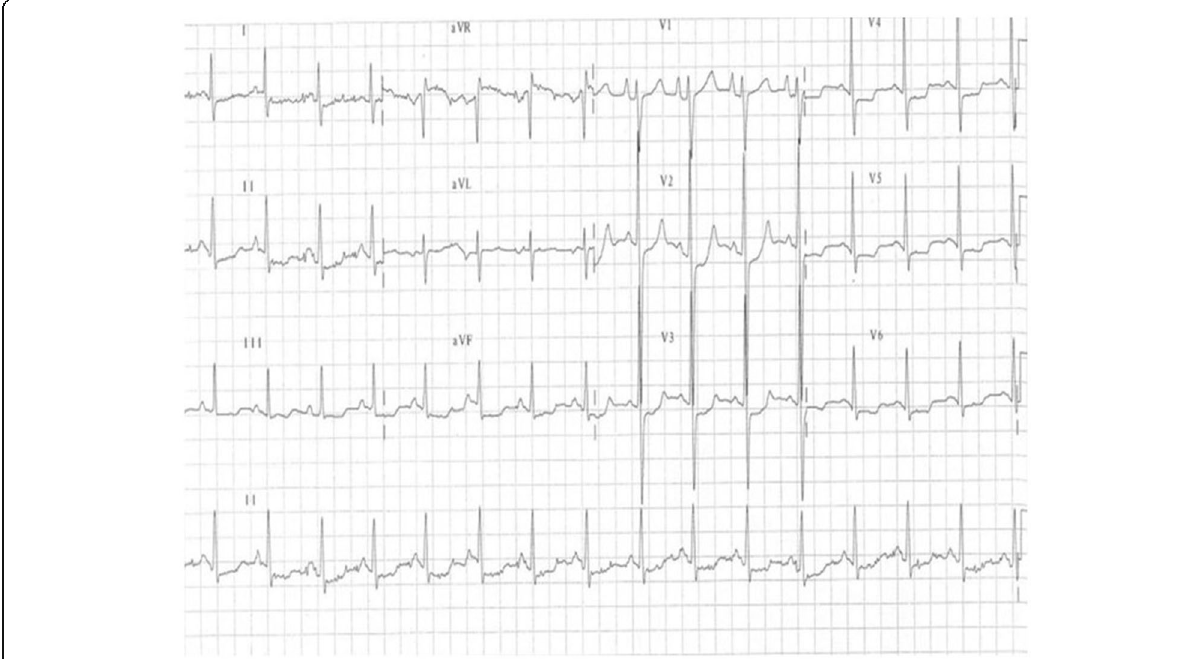
Fig. 1 Electrocardiogram shows sinus tachycardia, enlarged right atrium with left ventricular hypertrophy and secondary repolarization